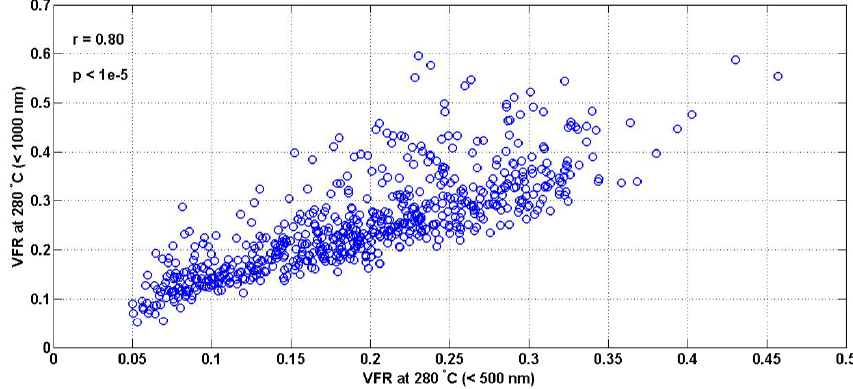
Fig. 2. Correlation between the VFR (DMPS and VDMPS < 1000nm) at 280 ◦ C and the VFR (DMPS and VDMPS < 500nm) at 280 ◦ C. Correlation coefficient ( r) and p-value describing the significance of the correlation are provided in the